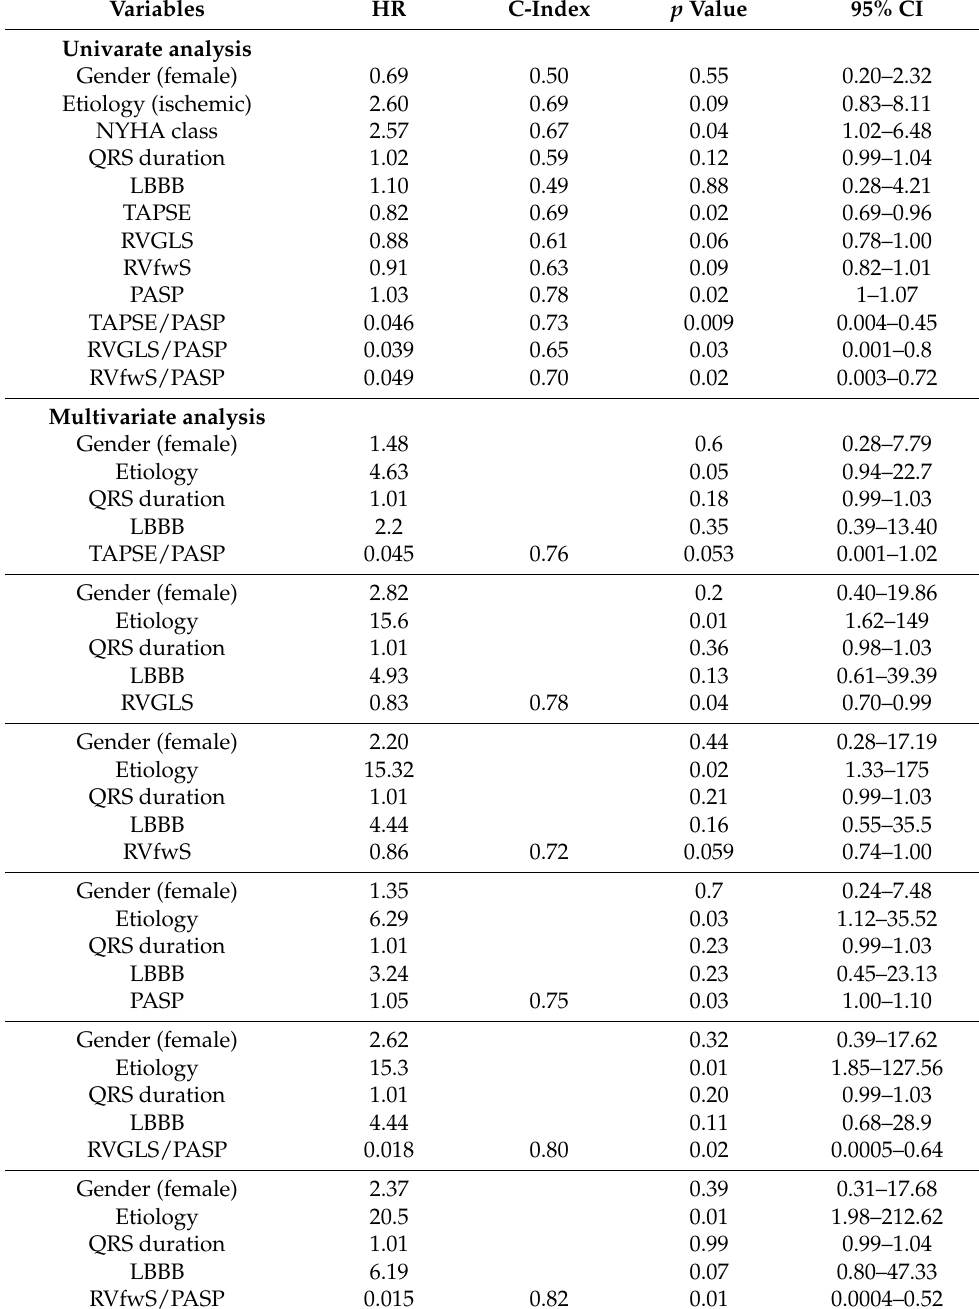
Table 3. Univariate and multivariate Cox regression survival analyses.